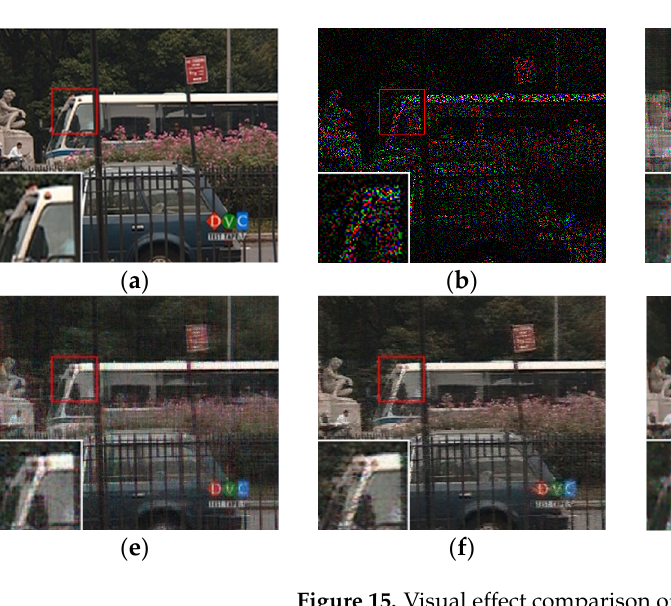
Figure 14. Visual effect comparison of different methods on the ninth frame completion of the Bus video. The incomplete video contains 50% missing entries. ( a ) Original image; ( b ) Incomplete image;